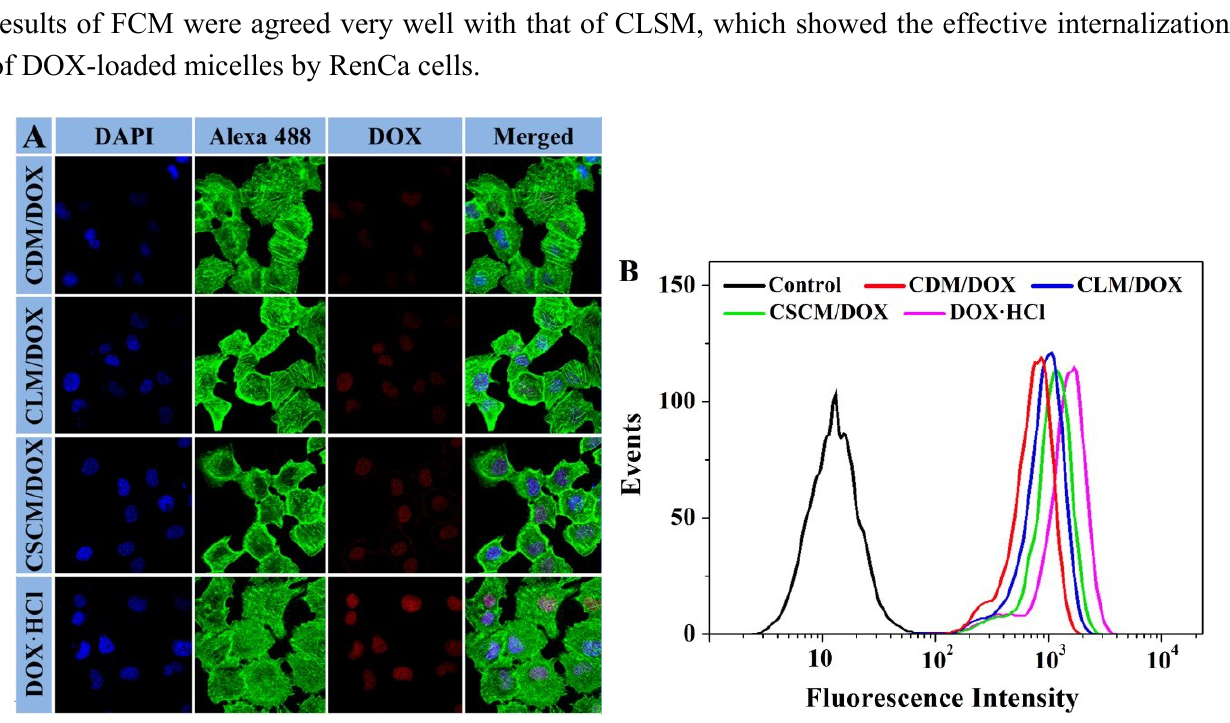
Figure 4. Typical CLSM microimages ( A ) and FCM determinations ( B ) of RenCa cells incubated with CDM/DOX, CLM/DOX, CSCM/DOX, or free DOX·HCl for 2